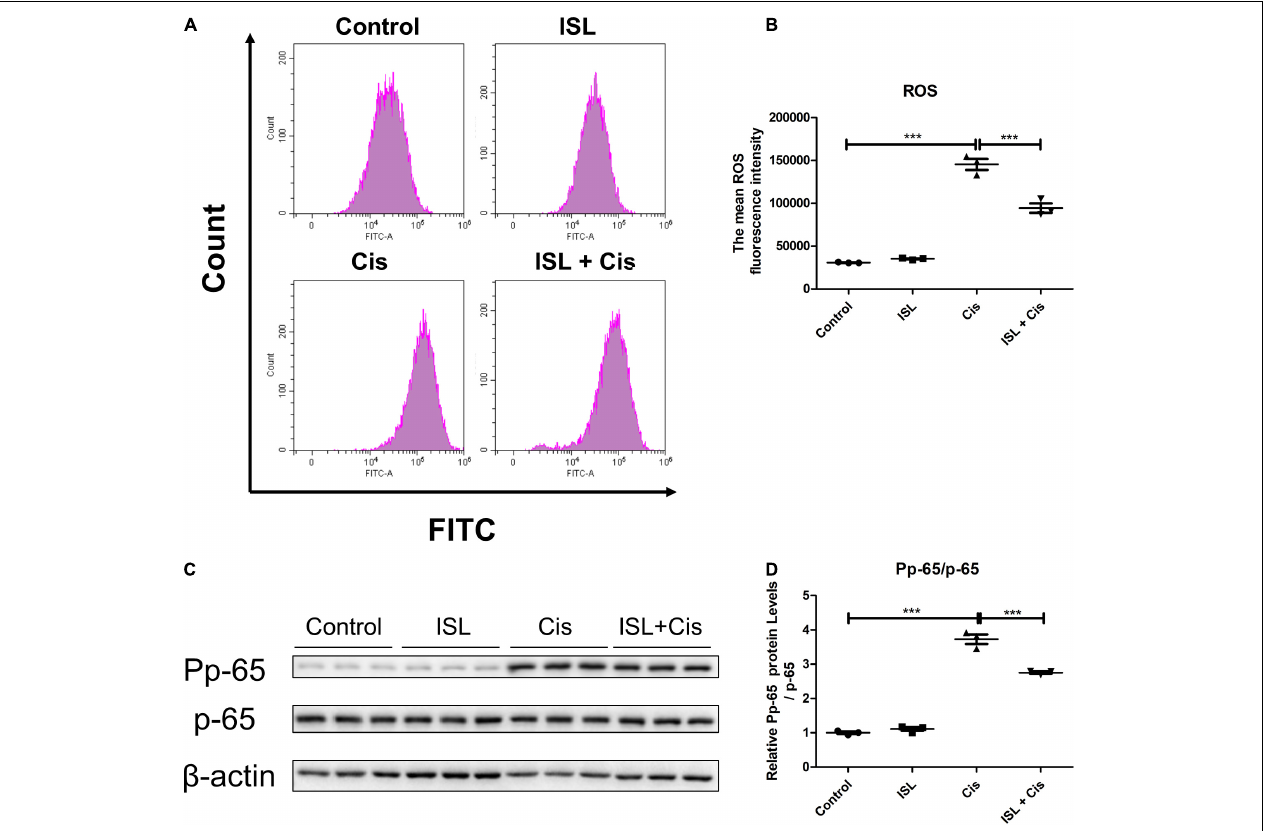
FIGURE 6 | ISL ameliorated cisplatin-induced inflammation and oxidative stress in HK2 cells. (A) The representative images of the flow cytometry data of ROS assay in HK2 cells. The HK2 cells were pretreated with 125 µ M ISL for 6–8 h, and then were administered 10 µ g/mL cisplatin for 24 h. (B) Quantitation of the mean fluorescence intensity ( n = 3 per group). (C) Representative western blots of Pp-65 and p-65 protein levels of HK2 cells pretreated with 125 µ M ISL for 6–8 h and administered 10 µ g/mL cisplatin for 24 h. β -actin was used as the internal reference. (D) Densitometry analysis of the western blots of Pp-65/p-65 ( n = 3 per group). The quantitative results were expressed as mean ± SD of each group. *** p < 0.001 (ANOVA with multiple comparison).